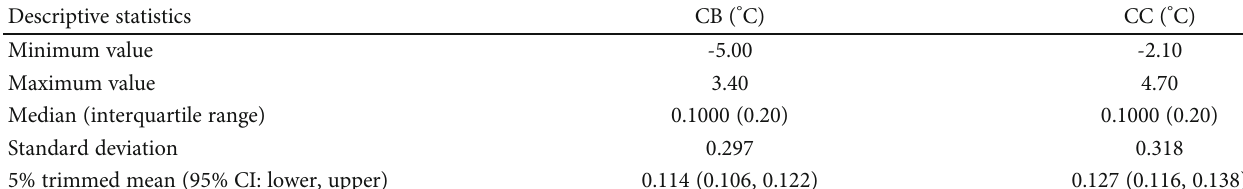
Table 4: Descriptive statistics for the skin temperature change per arm.